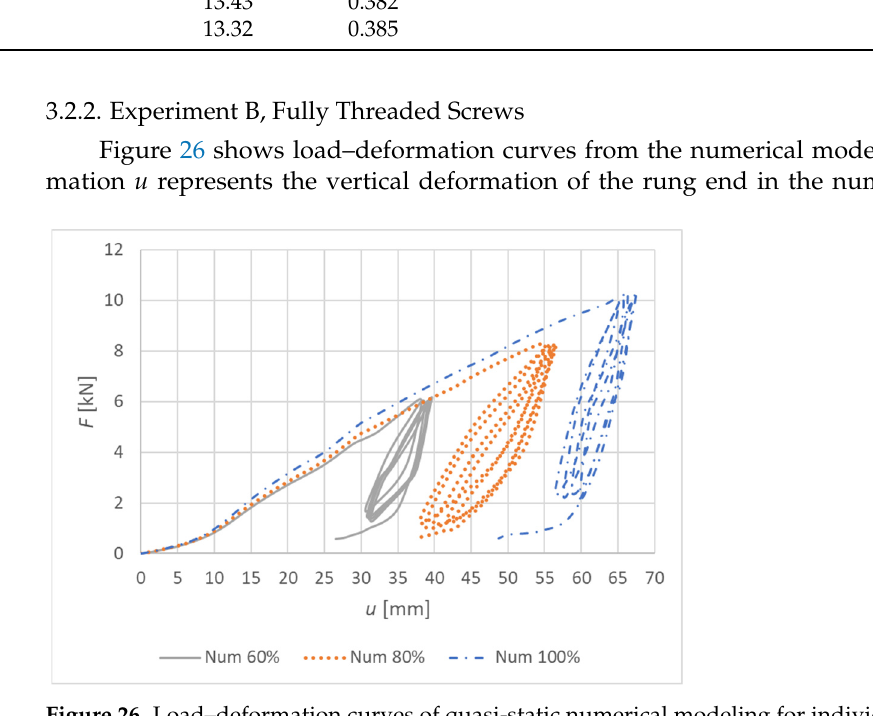
Figure 26. Load–deformation curves of quasi ‐ static numerical modeling for individual specimens made from fully threaded screws (Experiment B). made from fully threaded screws (Experiment